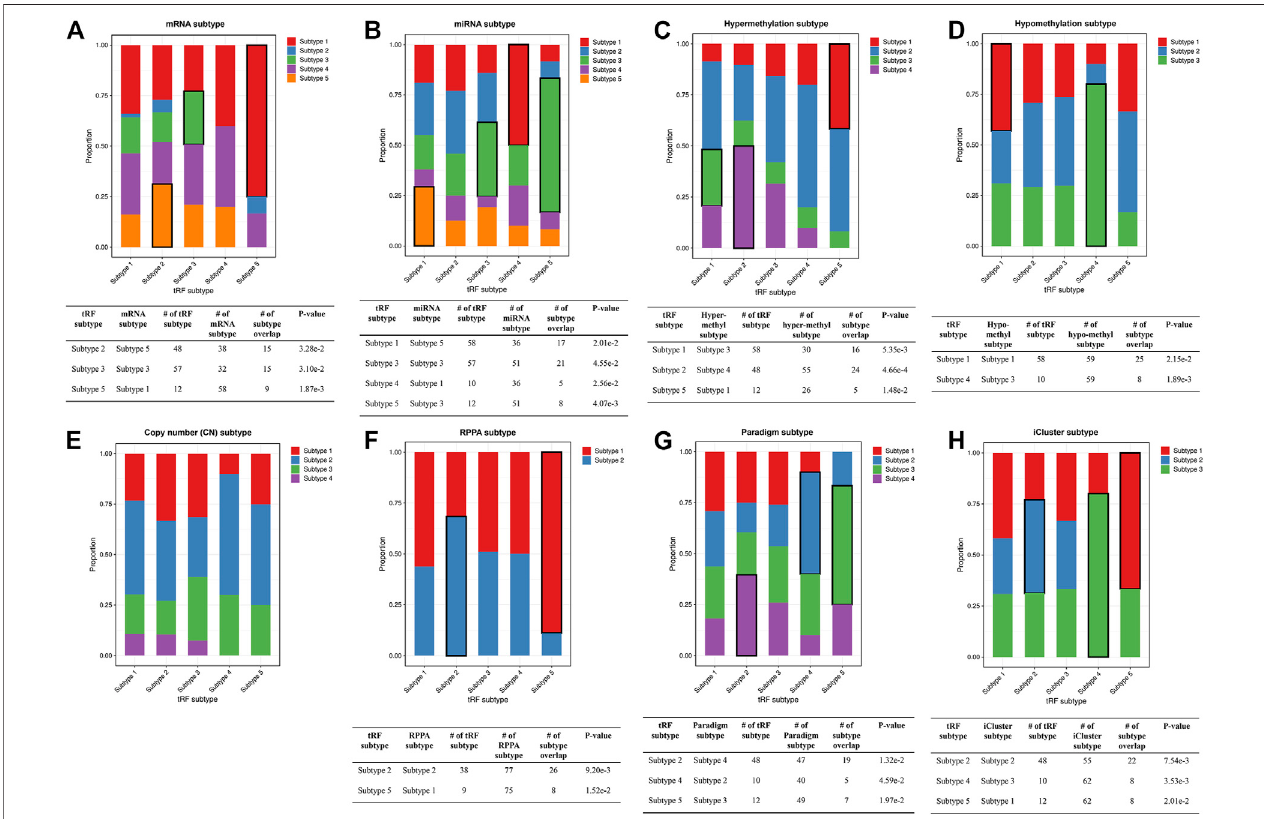
FIGURE 9 | Stacked bar plots showing the relations between ca-tRF subtypes and external subtypes in LIHC. Stacked bar plots showing the enrichment of externalsubtypes(clusteredbyTCGAConsortia)inca-tRFsubtypes,including (A) mRNAsubtypesidenti fi edbyconsensusclustering, (B) miRNAsubtypesidenti fi edby non-negative matrix factorization, (C – E) hyper-methylation, hypo-methylation and SNP-based copy number subtypes identi fi ed by hierarchical clustering, (F) protein subtypes (namely, RPPA subtypes) identi fi ed by consensus clustering, (G) Paradigm subtypes and (H) multi-omics subtypes identi fi ed by iCluster. The statistical signi fi cance was measured by Fisher ’ s exact test with the p -value cutoff 0.05 and the signi fi cant relations are highlighted by black frames. The sample numbers of subtypes and subtype overlaps presented in the signi fi cant relations are also shown in the tables